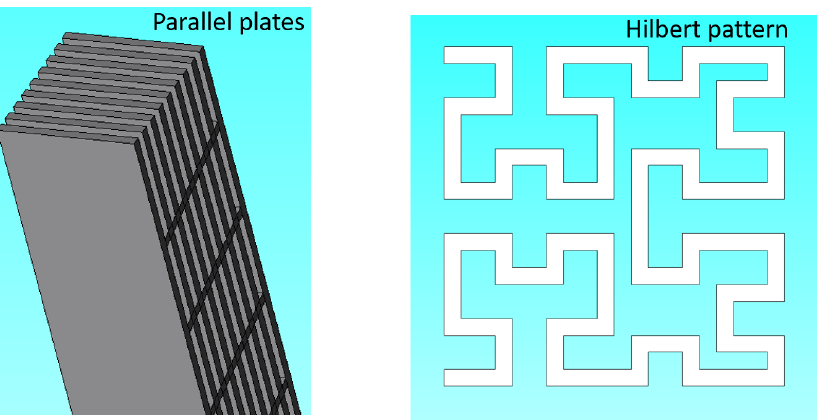
Figure 6. Examples of geometry structure in additive manufactured iron-silicon that can help with reducing eddy current loss. Printed iron-silicon with parallel plates or Hilbert cross-section can have a significant reduction in eddy current loss. Illustration adapted from [48].